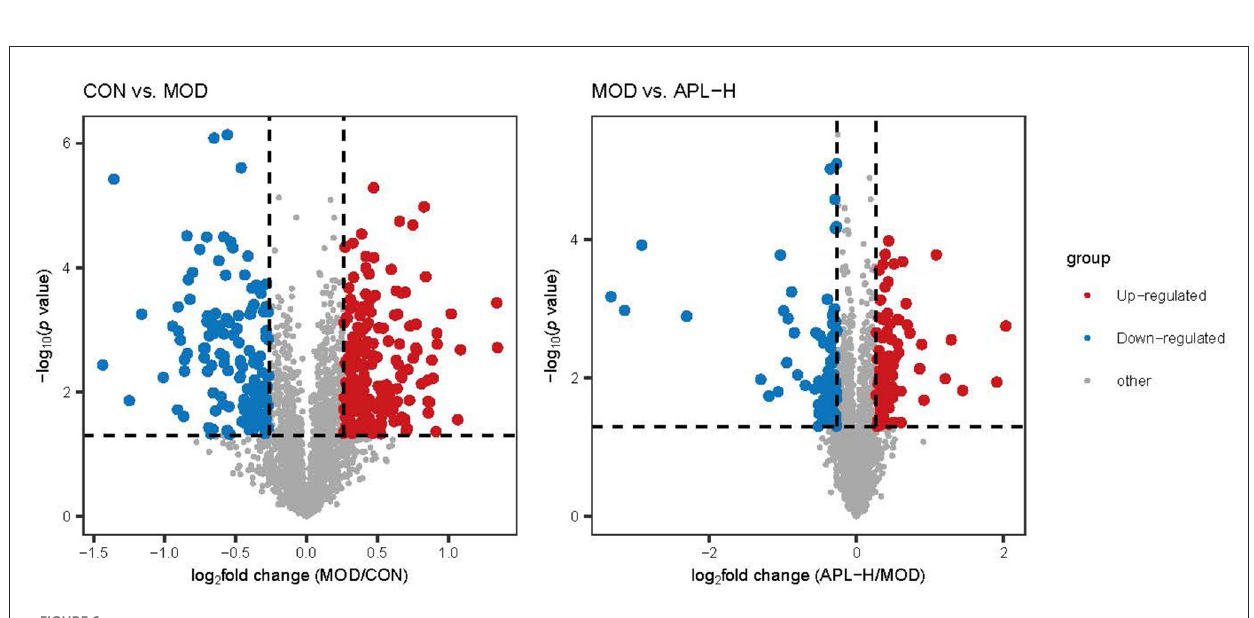
FIGURE6 Volcano plots of DEPs between different